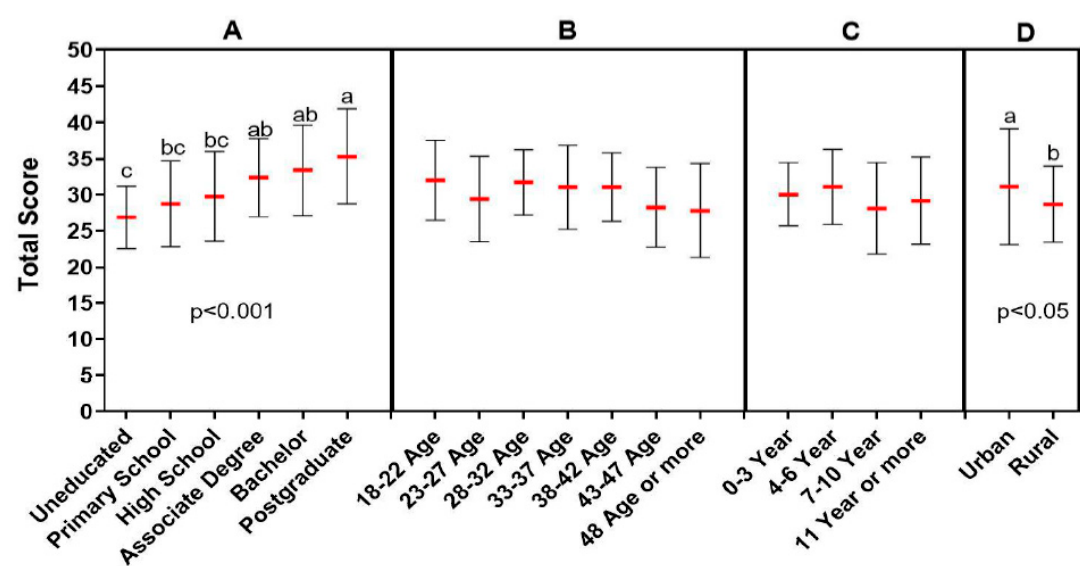
Figure 2. Association between antibiotic knowledge level and demographic data ( A : educational status, B : age, C : the time spent as farmer, D : place of residence). Each demographic data group was analyzed independently. The red lines indicate the mean value and the error bars indicate the standard deviation. Lower case letters (a, b, c) above the groups indicate statistical difference between the groups that is p < 0.05 and p < 0.001.